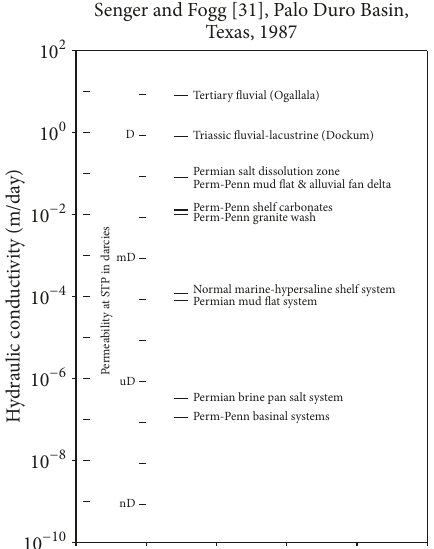
Figure 18: Hydraulic conductivity values used by Signor et al. [16]. Permeability values in square feet from four maps by Signor et al. [16] for hydrologic units in a study of the Great Plains of the United States. Mapped values increase from west to east, indicated by the open bars. Values between the Kansas/Colorado border and the Nemaha uplift lie within the solid (shaded) bars. Names of hydrologic units used by Signor et al. appear vertically in italics; equivalentnamesusedinthispaperappearverticallyinnormalfont. Scale for hydraulic conductivity units (md −1 ) used in this paper appears at left, using a conversion of 1md −1 = 1.19 × 10 −12 m 2 . Values given by Signor and others are permeability in ft-squared, taken from maps (Figures 21 , 22 , 29 , and 36 in Signor et al. [16]). Porosity values from geophysical logs were used to compute permeability estimates using the Kozeny-Carman equation. Conversion used is 𝐾 (m/d) = 1.28E-11 × k (ft-squared), at standard temperature and pressure.